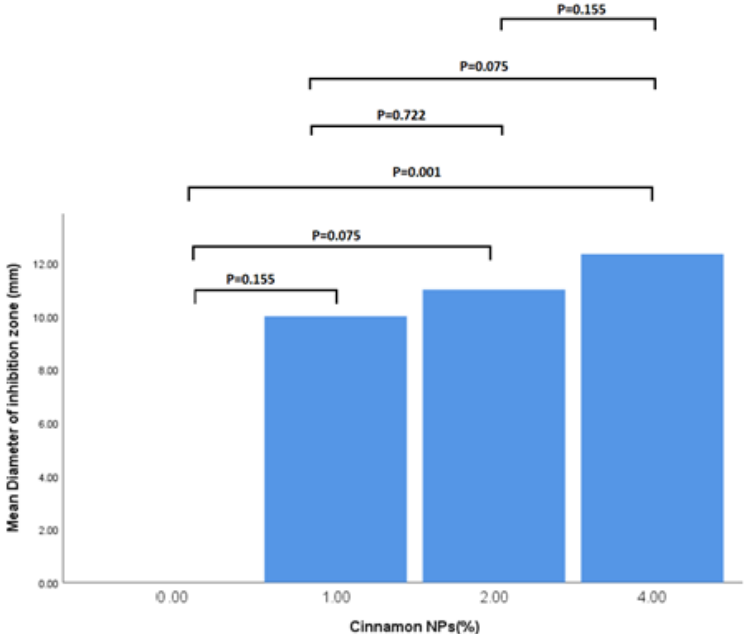
Figure 3. The result of the pairwise comparison test on the groups for cinnamon NPs addition into the GIC .